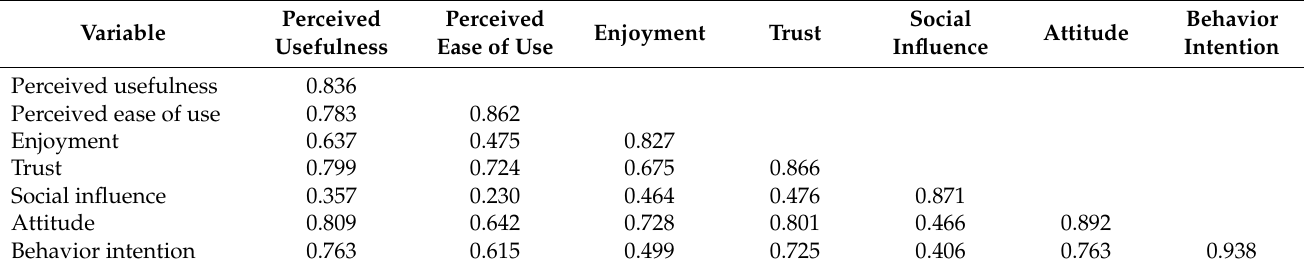
Table 3. Correlations and discriminant